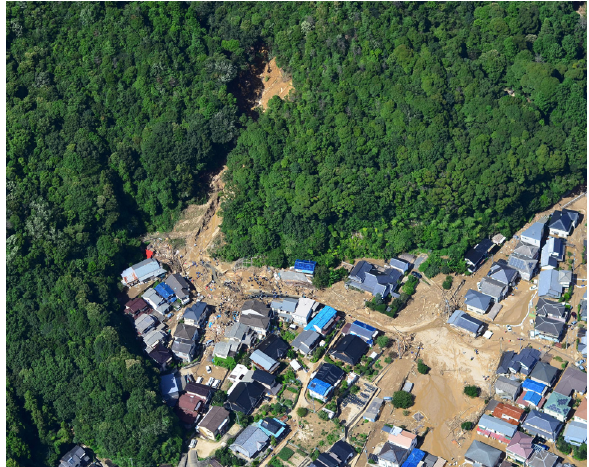
Figure 14. Asaminami Ward Yagi district (1).